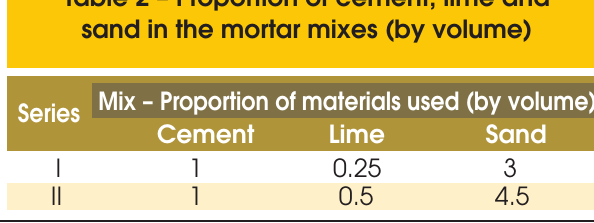
Table 2 – Proportion of cement, lime